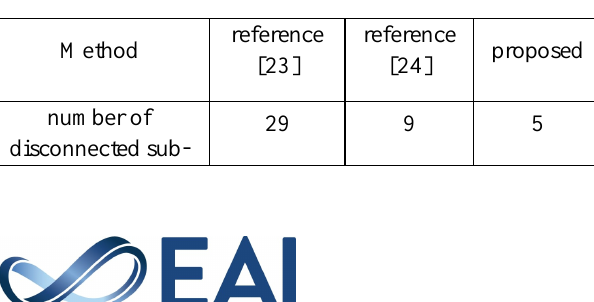
Table 4. The results of this method are